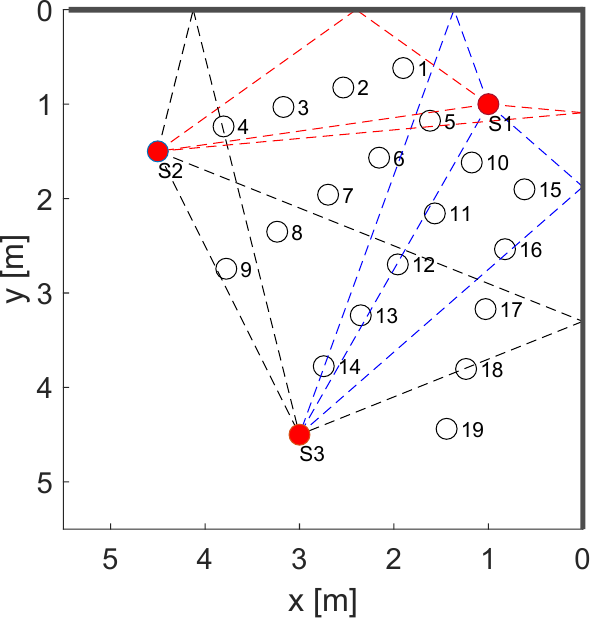
Figure 8. Sensor and measurements positions with signals paths of the MPCs up to the 1st order.